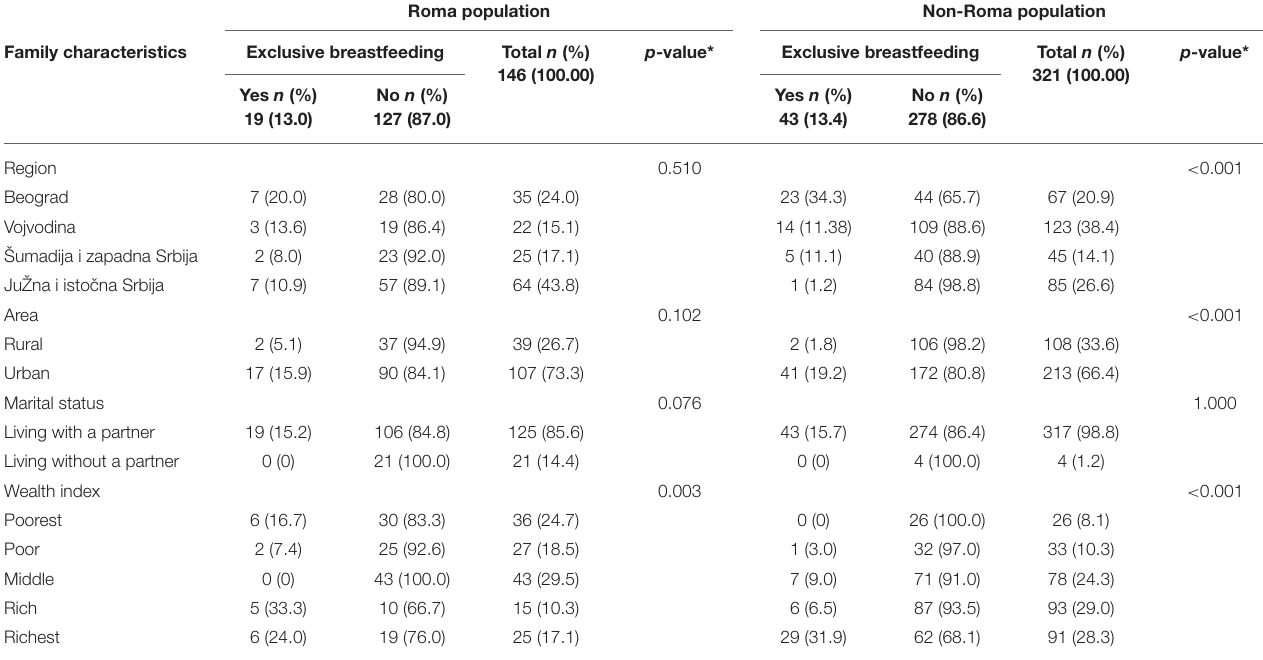
TABLE 1 | Family characteristics and practice of exclusive breastfeeding under the age of 6 months. Roma population Non-Roma population Family